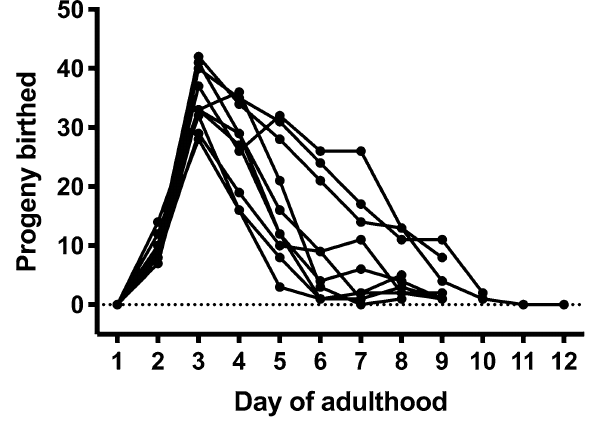
Figure 7. Fecundity of live-bearing hermaphrodites. Lines indicate progeny produced by individual adults, with points representing progeny counts. Line ends indicate the death of the adult.